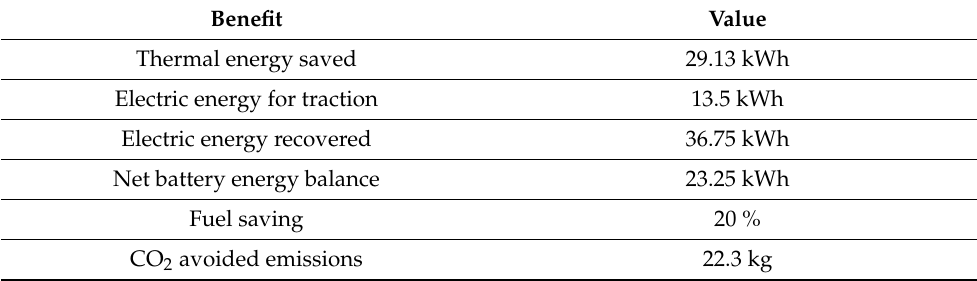
Table 3. Results concerning thermal energy saving, battery energy flows, avoided emissions and fuel